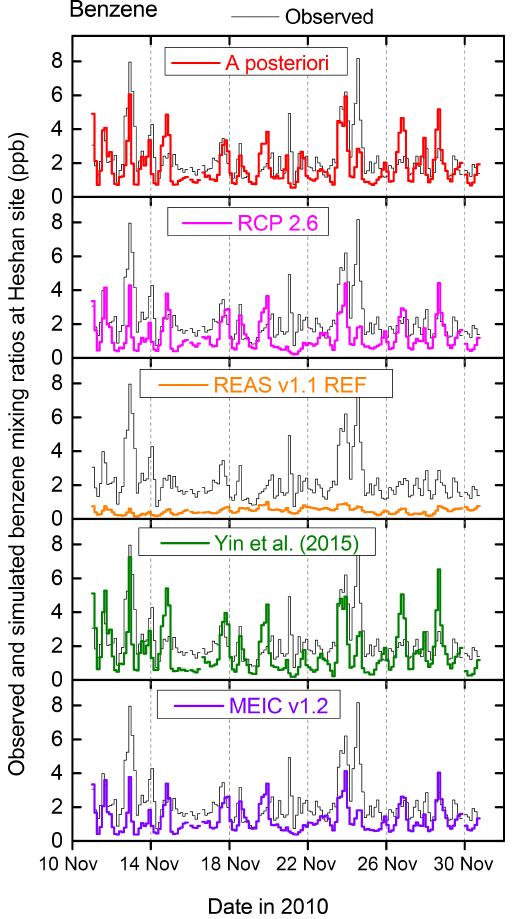
Figure 7. Time series of observed and simulated benzene mixing ratios at the Heshan site. The simulations use emission fields from inversion in this study, RCP2.6, REAS v1.1 REF, Yin et al. (2015), and MEIC v1.2,